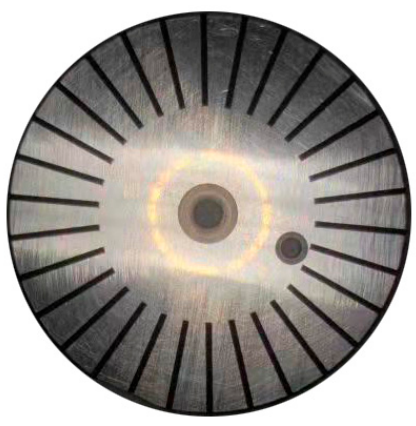
Figure 2. Picosecond texture.